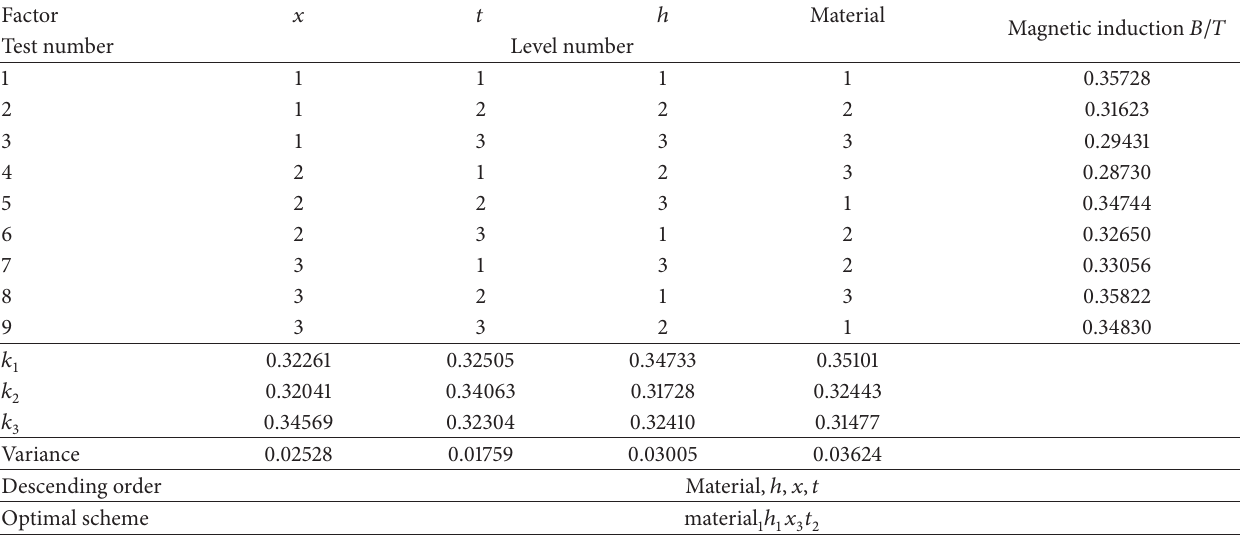
Table 6: The experimental scheme and results.